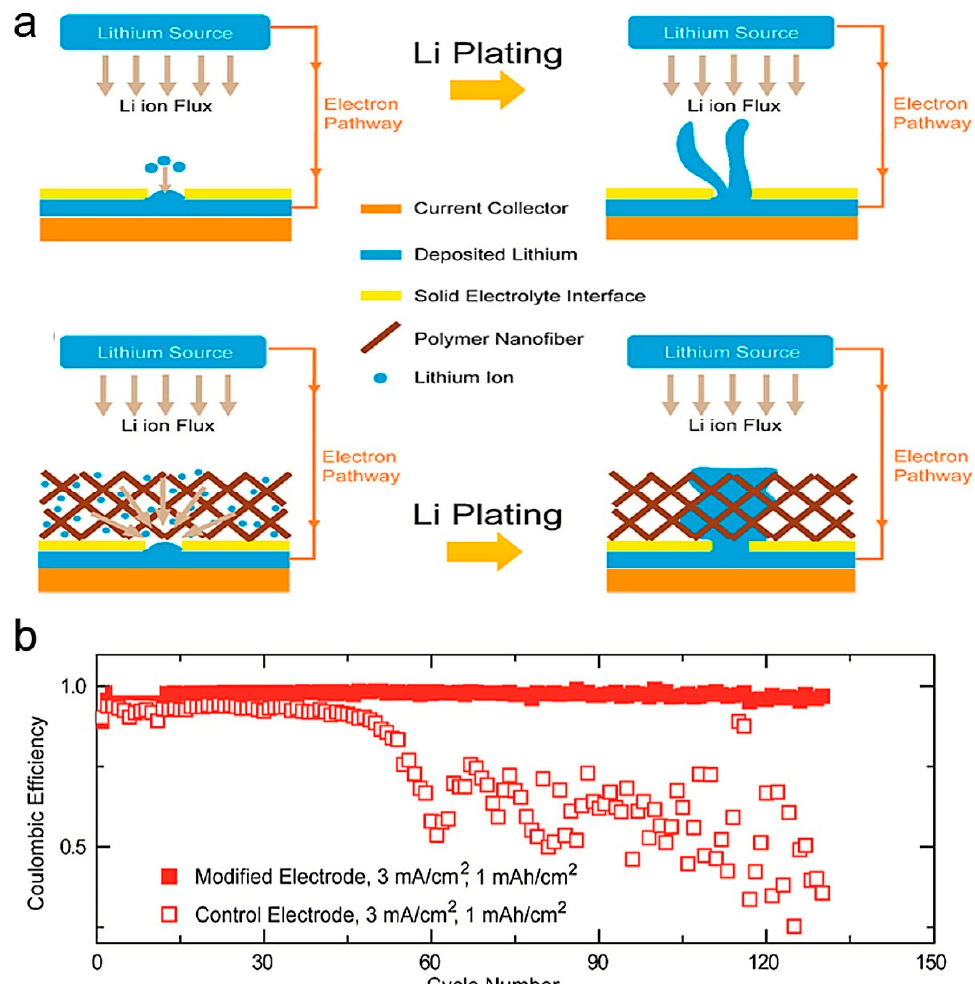
Figure 6. ( a ) Schematic illustration of lithium deposition on bare copper electrode and polymer nan- ofiber network modified Cu electrode. ( b ) Comparison of the Coulombic efficiency of Li deposition on bare Cu and Cu-OxPAN electrode with current densities of 3 mA cm − 2 . The amount of Li plated in each cycle is 1 mAh cm − 2 . Reproduced with permission [62]. Copyright 2015, American Chemical Society.